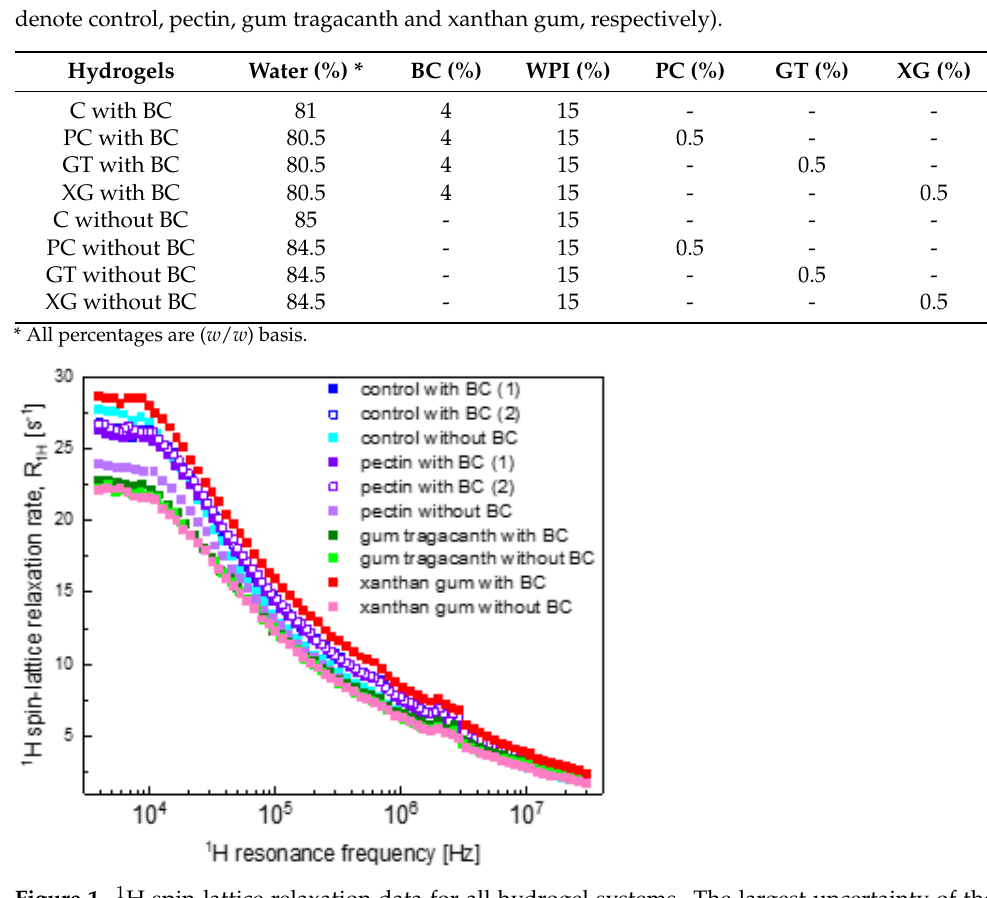
Figure 1. 1 H spin ‐ lattice relaxation data for all hydrogel systems. The largest uncertainty of the values is 5.6%; for the majority of the relaxation rates the uncertainty is of the order of 3%. In Figure 1, one sees two data sets for the control samples containing BC (referred to as “control with BC(1) and BC(2)”) and the pectin samples containing BC (referred to as “pectin with BC(1) and BC(2)”). The data were collected for two samples of the same for ‐ mulation to show reproducibility of the results. Figure 2 shows a 1 H spin ‐ lattice relaxation curve for the control hydrogels without BC and with BC. As expected, the parameters for the control systems do not differ much (Table 2). The translation diffusion coefficients are of the order of 1 × 10 − 11 m 2 /s, which makes the translation diffusion by about 500 times slower compared to water in bulk. The correlation time 𝜏 (cid:3030) is of the order of 2 × 10 − 6 s. The similar values of the dipolar relaxation constant 𝐶 (cid:3005)(cid:3005)(cid:3036)(cid:3041)(cid:3047)(cid:3045)(cid:3028) indicate that the mole fractions of water molecules bound to the macro ‐ molecular network are very similar in both cases, while the slightly different values of 𝐶 (cid:3005)(cid:3005)(cid:3036)(cid:3041)(cid:3047)(cid:3032)(cid:3045) indicate that the number of water molecules per unit volume in the confined ‐ water fraction is somewhat different.